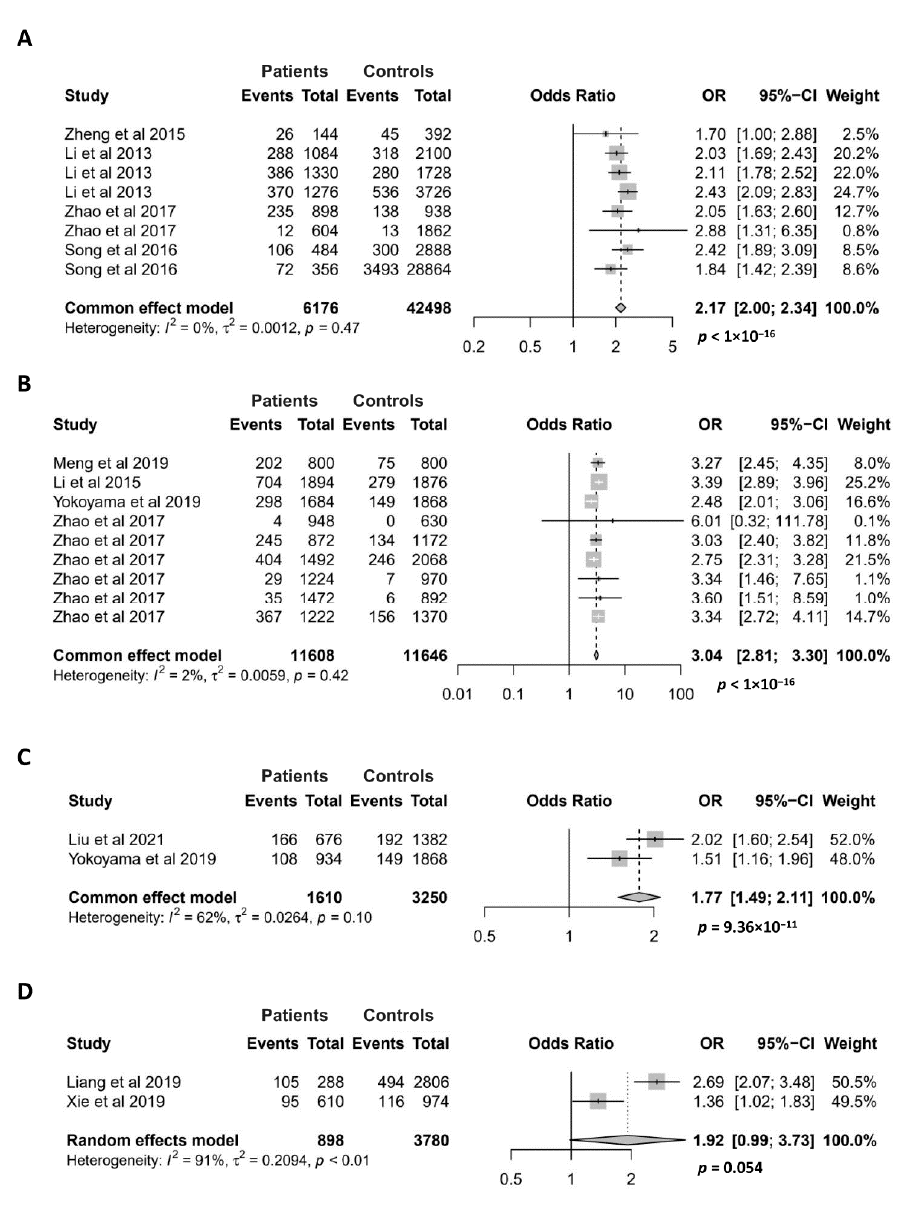
Figure 4. Association of the GTF2I rs117026326 polymorphism with pSS ( A ), SLE ( B ), SSc ( C ), and NMOSD ( D ). Data derived from the meta-analysis are presented as forest plot. Odds ratios (OR) and 95% confidence intervals (CI) of individual studies are represented by squares and horizontal lines, respectively. Size of the square represents the weight of the individual study in the meta-analysis. Diamonds represent the OR (center line of the respective diamond) and 95% CI (lateral tips of the respective diamond). The OR, 95% CI and p values for the meta-analysis are indicated by bold